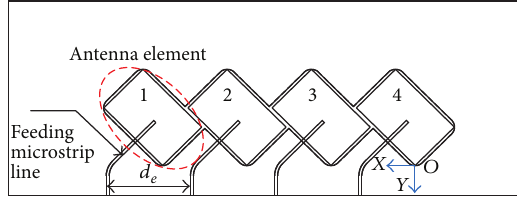
Figure 10: Configuration of the 1 × 4 IMF-CBSA array without feeding network.